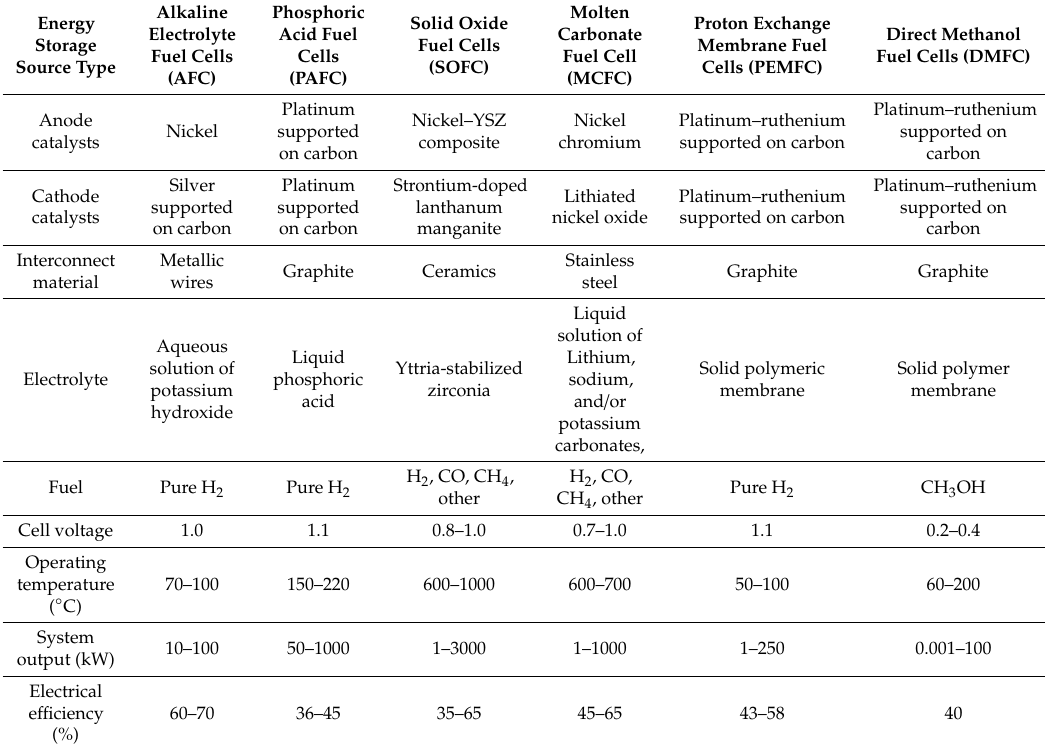
Table 6. Summary of fuel cell characteristics